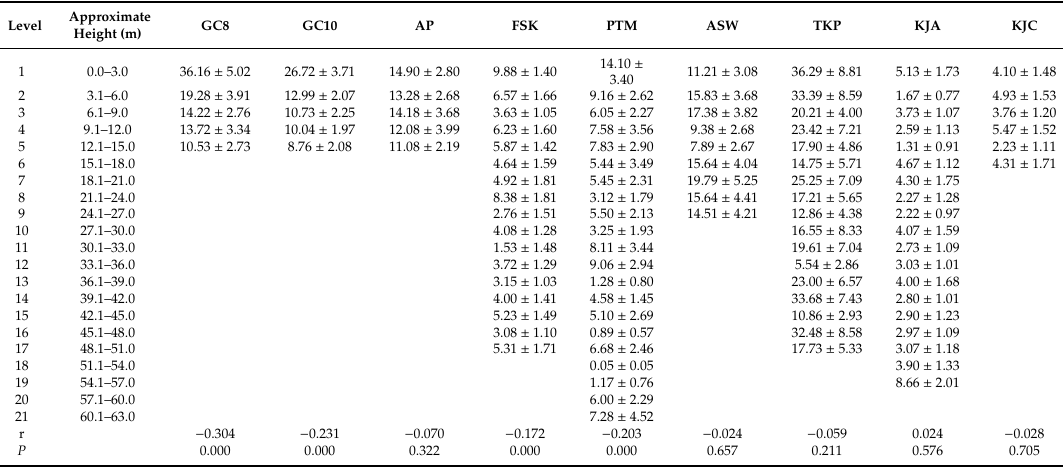
Table 4. The mean number of Aedes larvae per ovitrap on each level. Spearman’s rank correlation coe ffi cient between the mean number of Aedes larvae and level (height) was calculated using SPSS